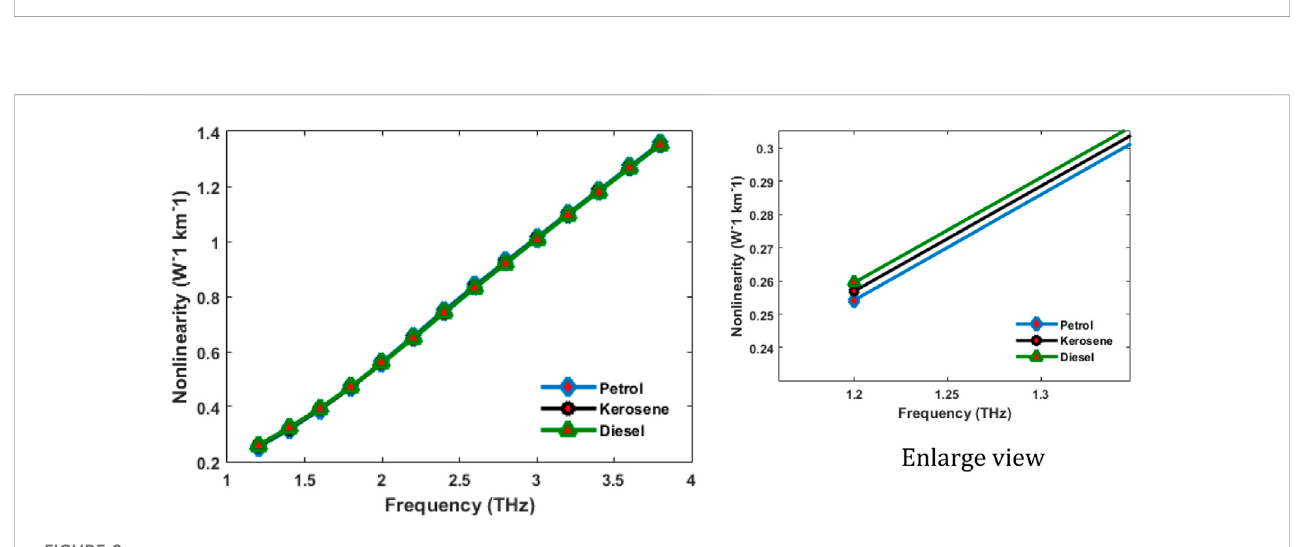
FIGURE 8 Non-linearity vs. operating frequency.